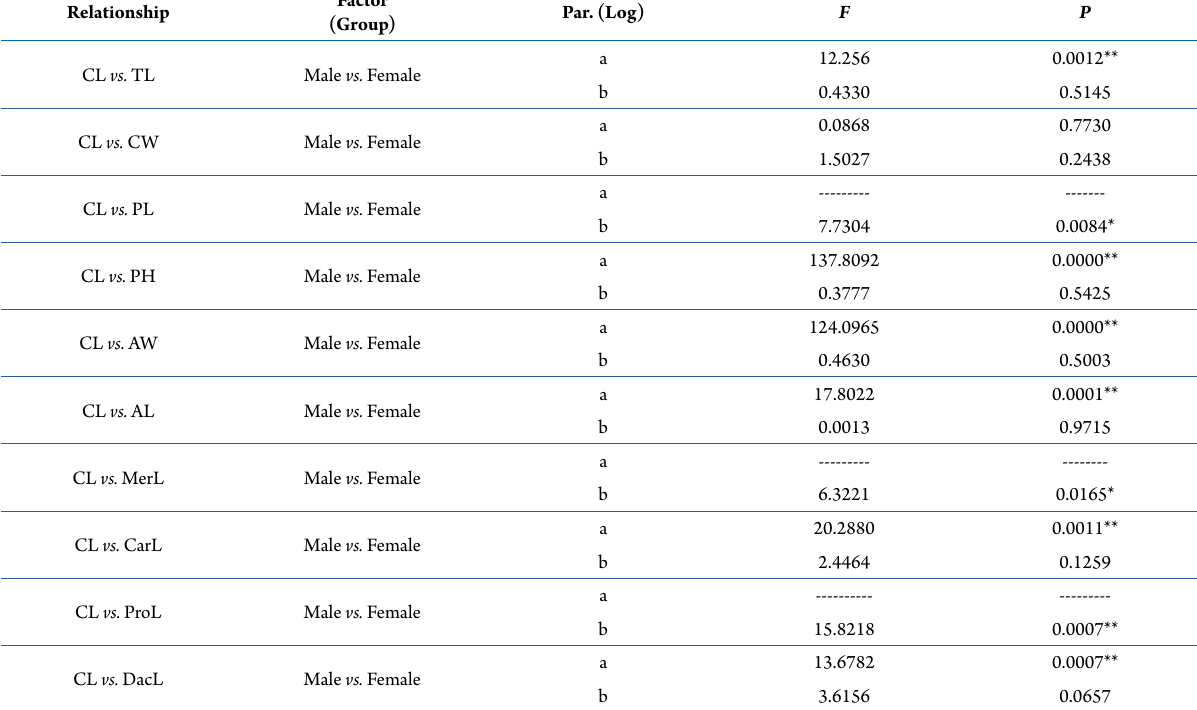
Table 1. Results of the Covariance Analysis (ANCOVA) of morphometric data for Atya gabonensis Giebel, 1875 at the Fluvial Island Domain in the Paraíba do Sul River basin. (CL) carapace length, (PL) length of the second abdominal pleuron, (PH) height of the second abdominal pleuron, (CW) carapace width, (TL) total length, (AW) abdomen width, (AL) abdomen length, (MerL) merus length, (CarL) carpus length, (ProL) propodus length, (DacL) dactylus length. Significant difference: * P <0.05; ** P